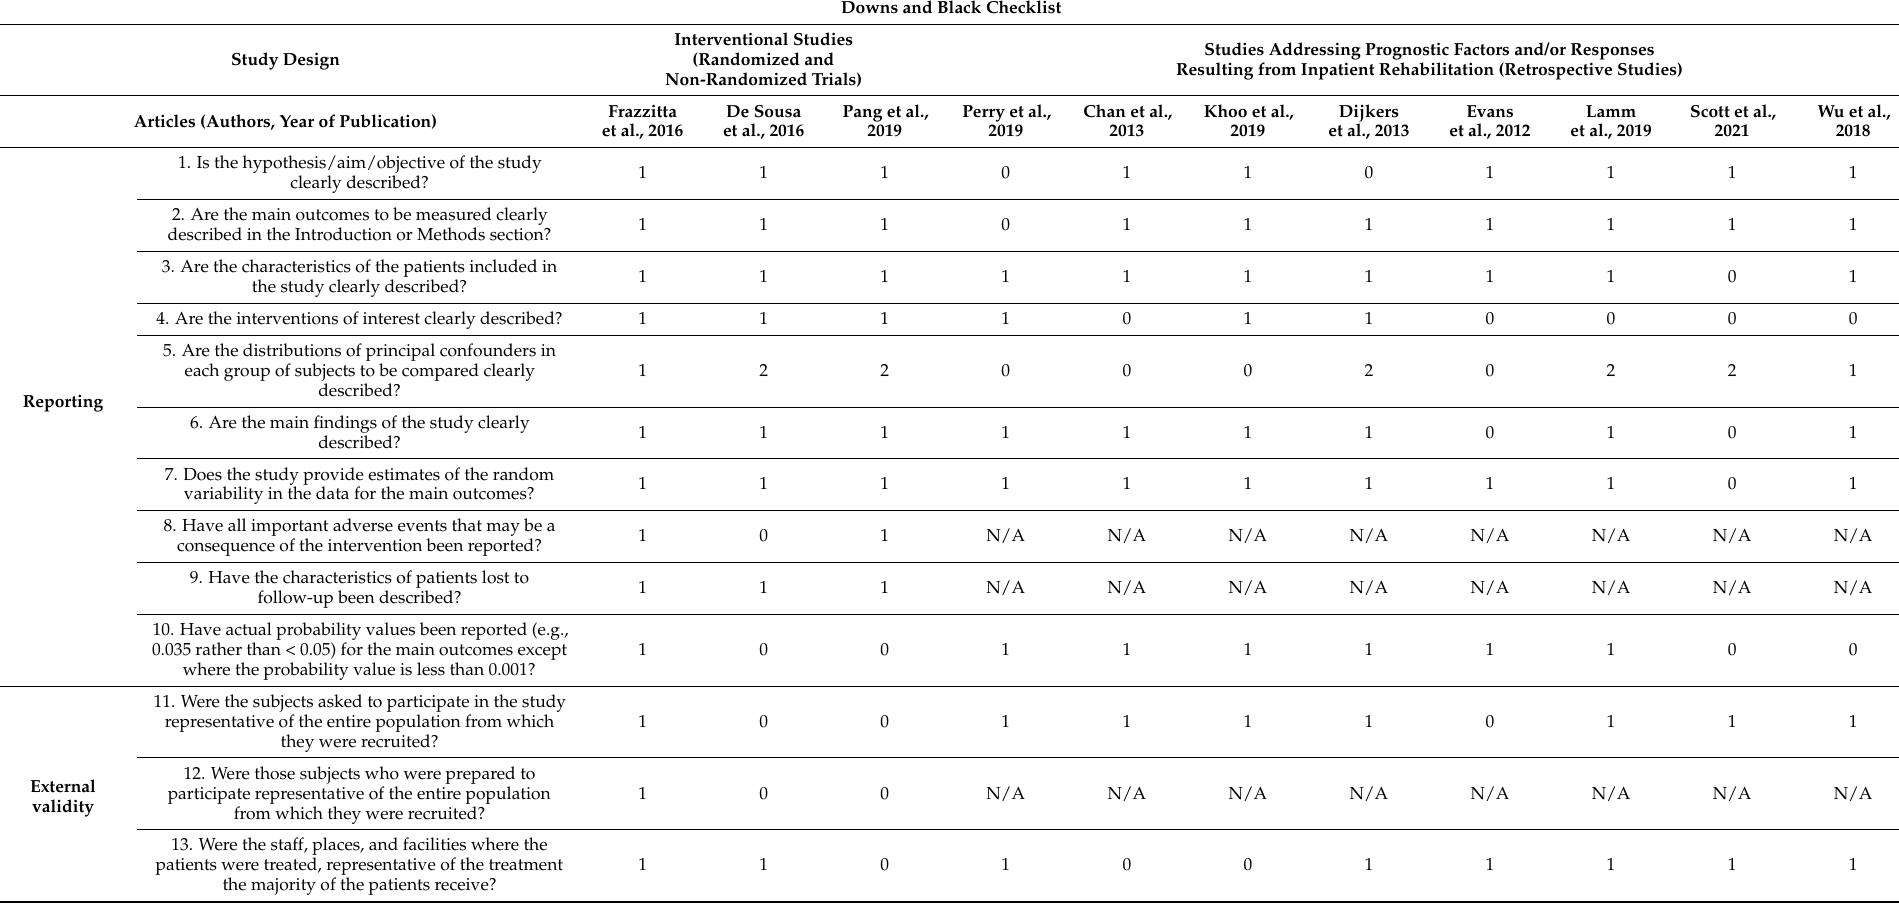
Table A1. Downs and Black Checklist for Measuring Study Quality: Summary of included